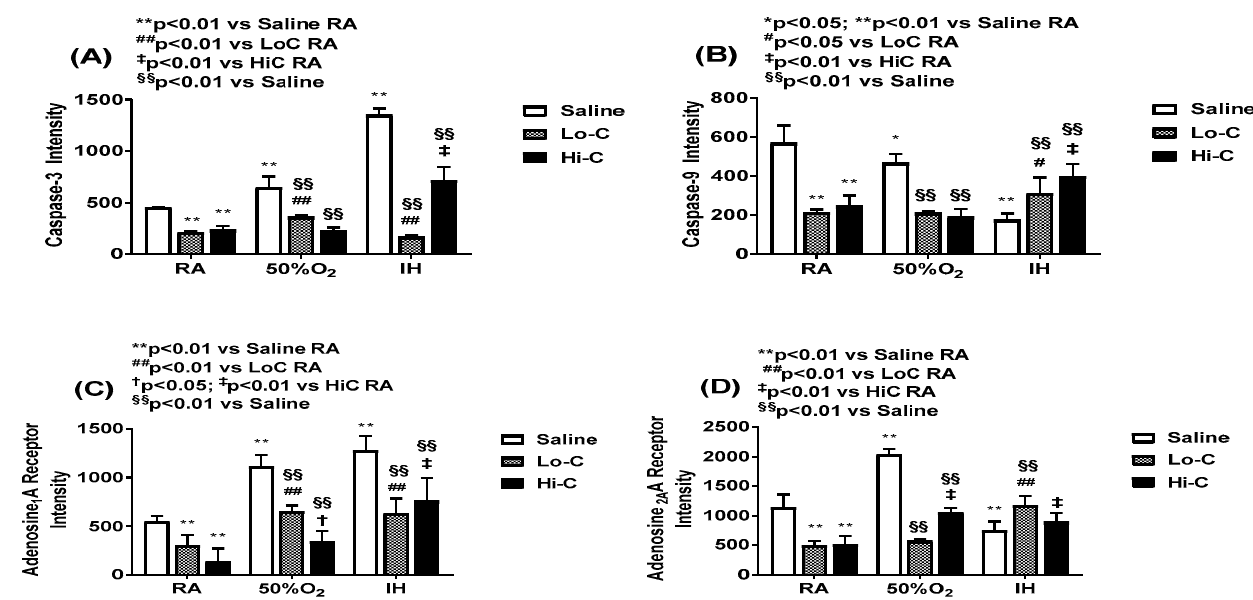
Figure 9. Quantitative analysis of caspase-3 (panel A ), caspase-9 (panel B ), A 1 R (panel C ) and A 2A R (panel D ) immunoreac- tivity presented in Figures 6–9. Groups are as described in Figure 1. A two-way ANOVA was conducted to examine the effects of oxygen environment (factor 1) and treatment (factor 2) with Dunnett’s 2-sided multiple comparison post hoc test. Saline was used as the control for the treatment groups within each oxygen environment; and room air (RA) was used as the control among the oxygen groups for each treatment. Panel A: F(4,99) = 7.784, p < 0.01; Panel B: F(4,99) = 10.562, p < 0.01; Panel C: F(4,99) = 4.029, p < 0.01; Panel D: F(4,99) = 7.801, p < 0.01. * p < 0.05, ** p < 0.01 vs. Saline RA; # p < 0.05, ## p < 0.01 vs. LoC RA; † p < 0.05, ‡ p < 0.01 vs. HiC RA; and §§ p < 0.01 vs. Saline in each oxygen environment. Data are presented as mean ± SEM ( n = 12